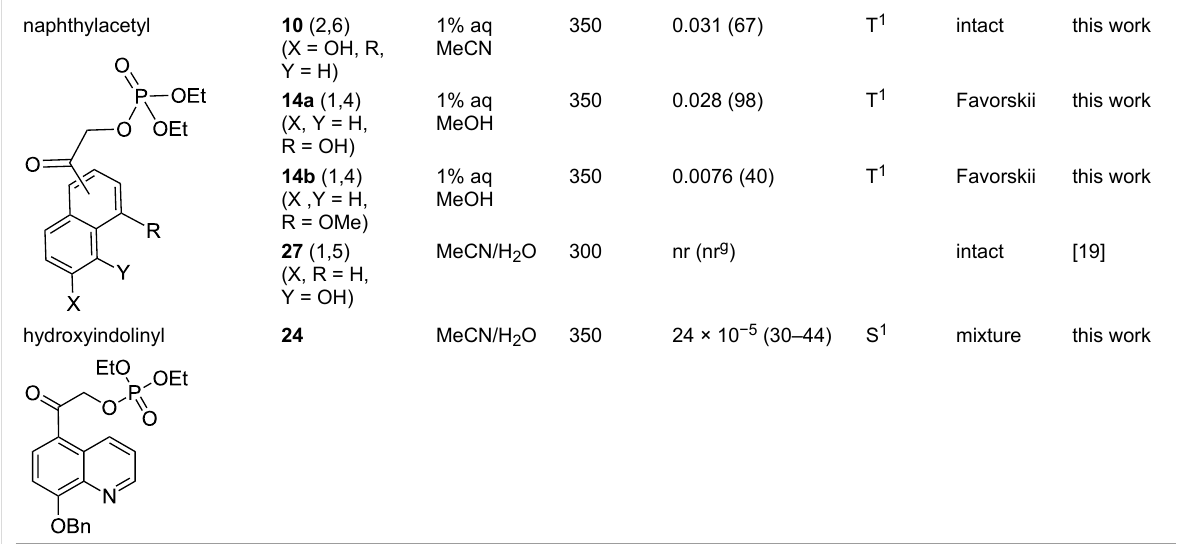
Table 4: A comparison of photorelease from cages for diethyl phosphates. Chemical yields, quantum yields, efficiencies and complexity based on solvents and chromophores. (continued)